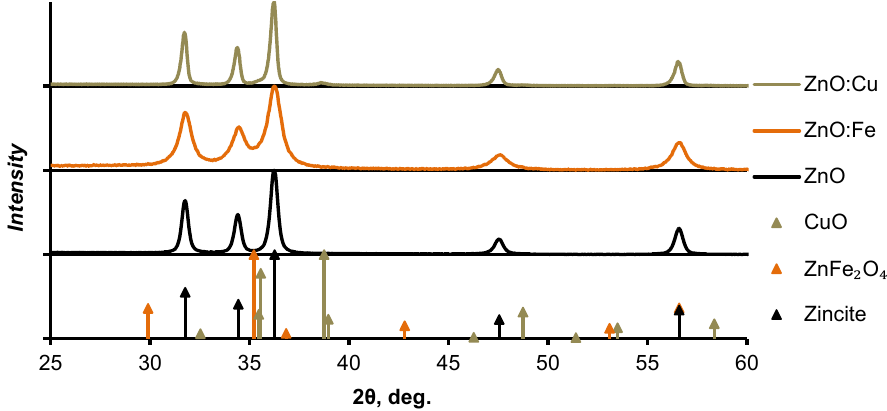
Figure 3. X-ray diffractograms of the pure ZnO, ZnO:Cu, and ZnO:Fe nanopowders. XRD patterns of the zincite [39], copper (II) oxide [38], and zinc ferrite [40].